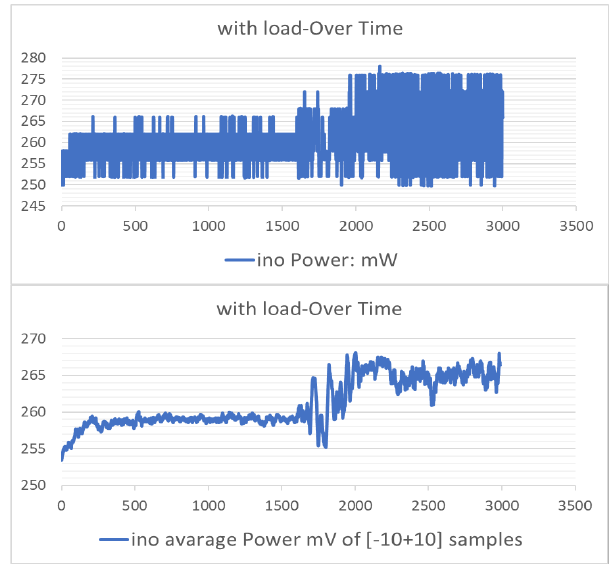
Figure 34. 1 h running Arduino in load